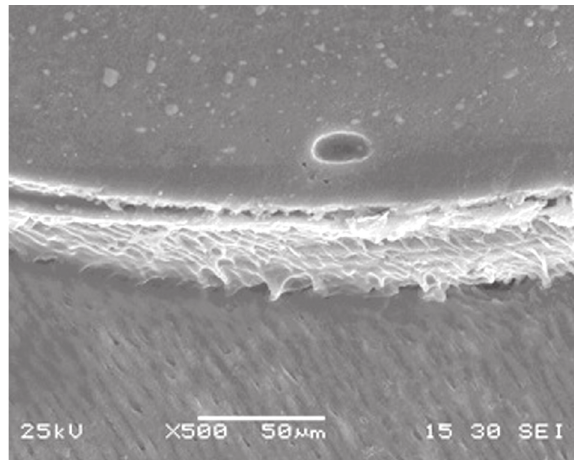
Figure 7- Photomicrograph of flat vestibular surface restored with restored with P90/Silorane Adhesive System